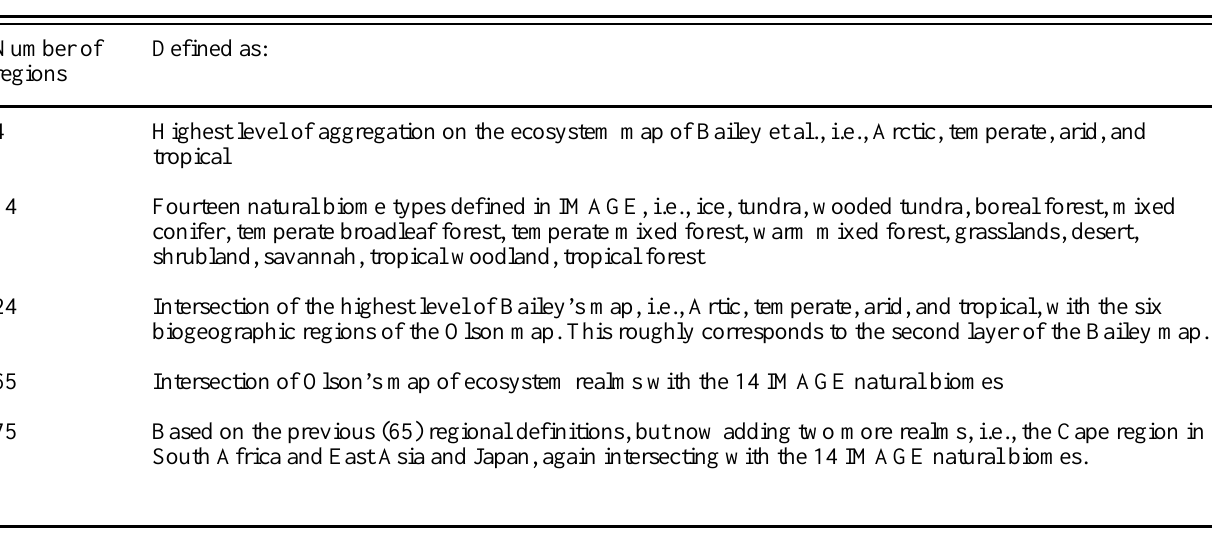
Table 3. Regional definitions